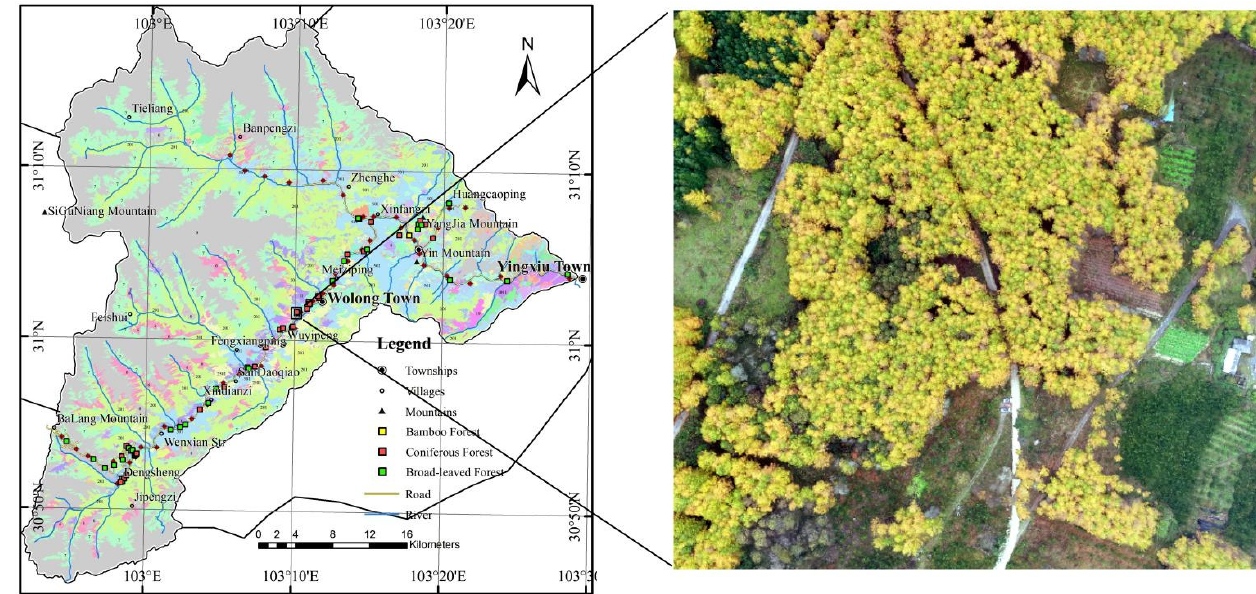
Figure 2. Forest phase map and sampling points in the study